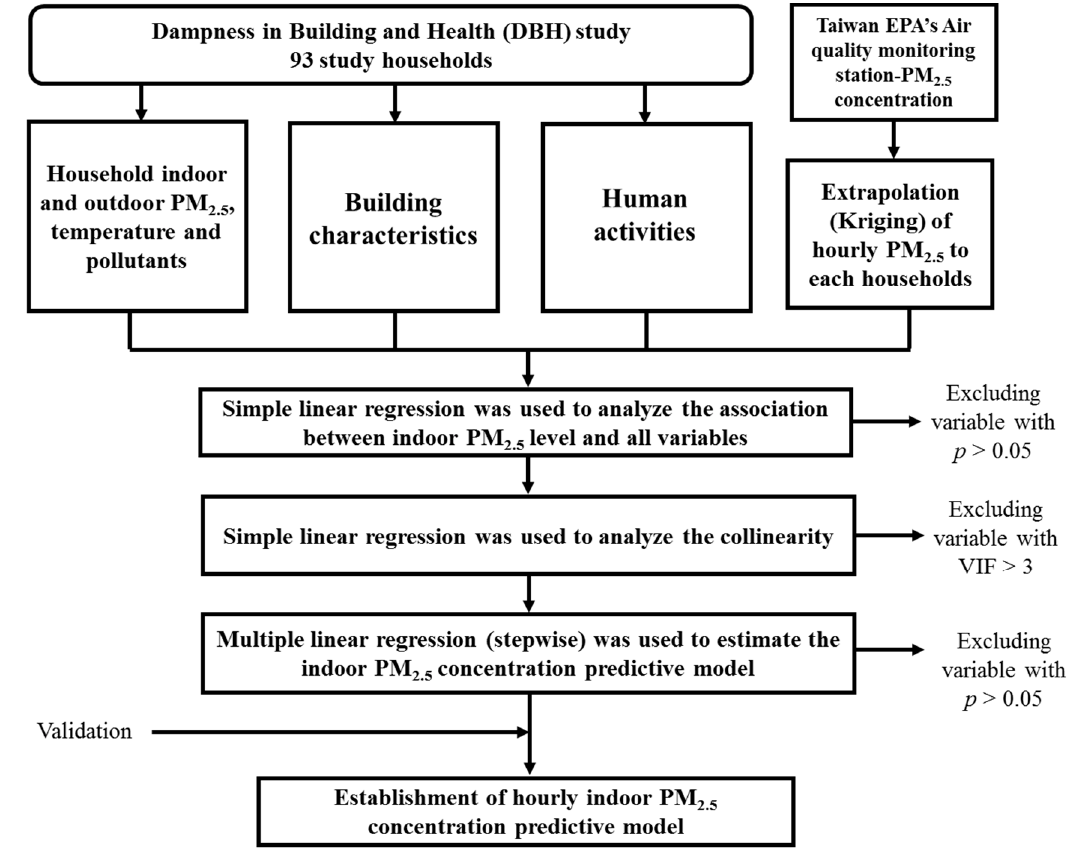
Figure 1. Flowchart of developing the hourly indoor particulate matter (PM) 2.5 concentration prediction model.